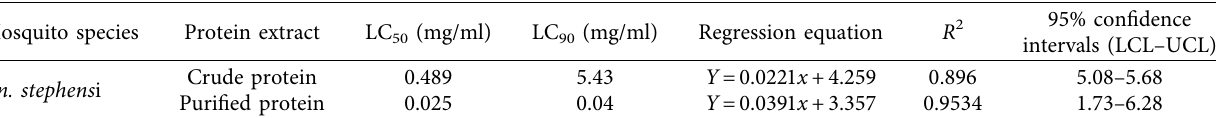
Table 3: Te LC 50 and LC 90 values of crude and purifed plant proteins against third instar larvae of An. stephensi . Mosquito species